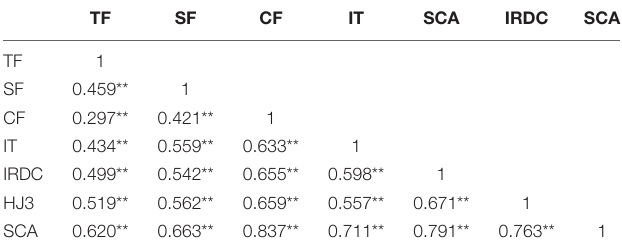
TABLE 2 | Square root of AVE and factor correlation coefficients.